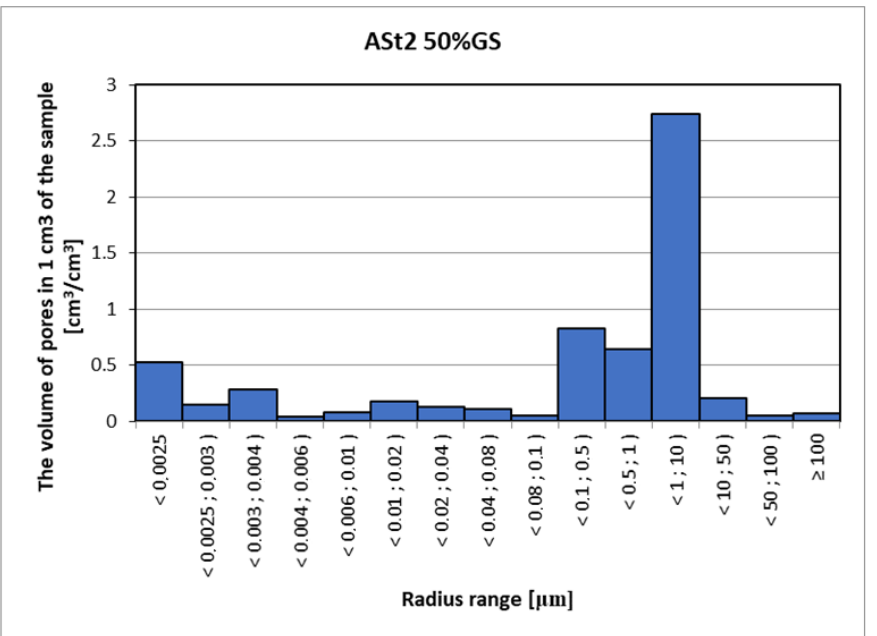
Figure 17. Distribution of the volume and range of pore radii for traditional sand-lime brick.